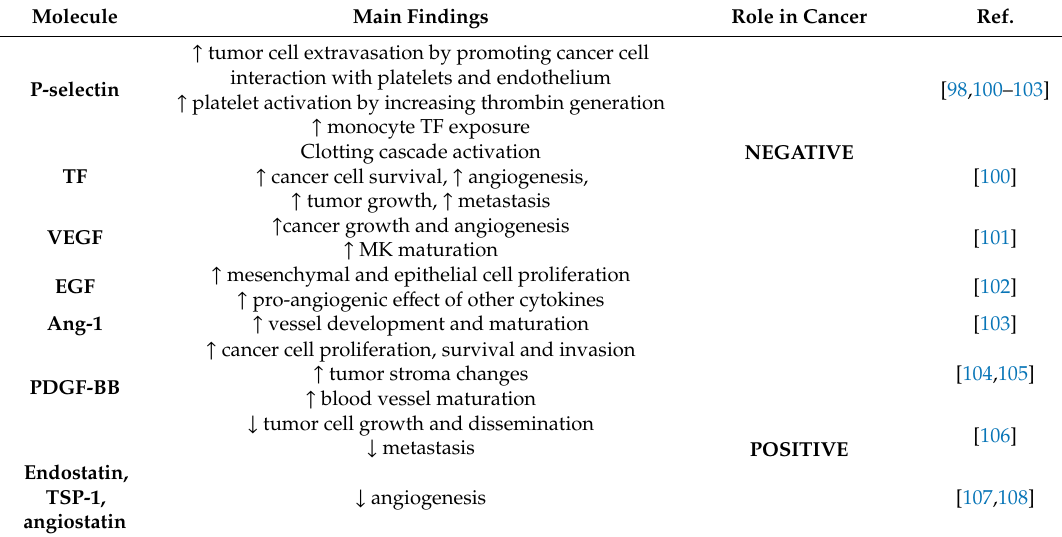
Table 2. Main platelet-derived proteins involved in